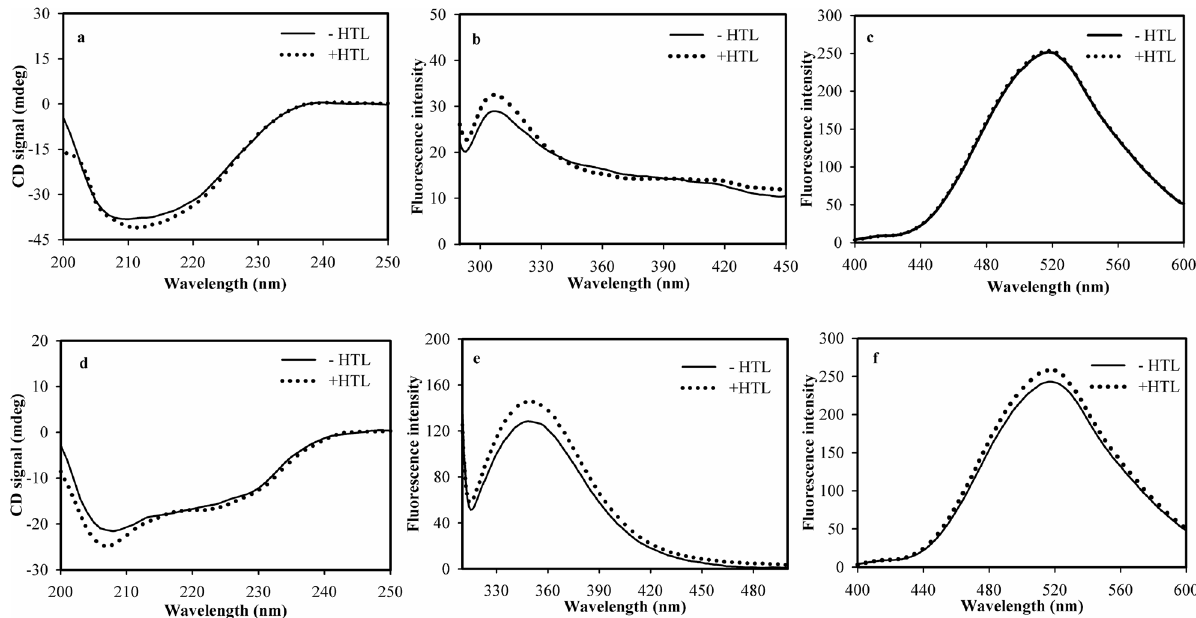
Figure 3. Conformational changes of the HTL-modified RNase-A and Lyz. Far UV CD spectra (left panel), intrinsic fluorescence spectra (middle panel), and ANS-binding spectra (right panel) of HTL-modified RNase-A and Lyz. The structures represent modified samples of day